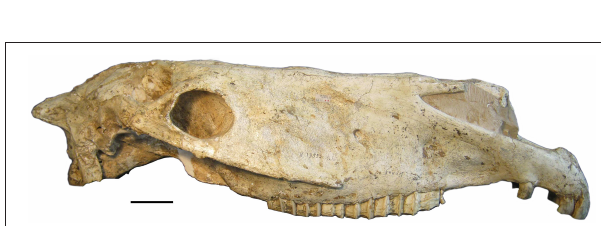
FIGURE 9 | Comparison of basicranial proportion in several extinct and extant species of Equidea.